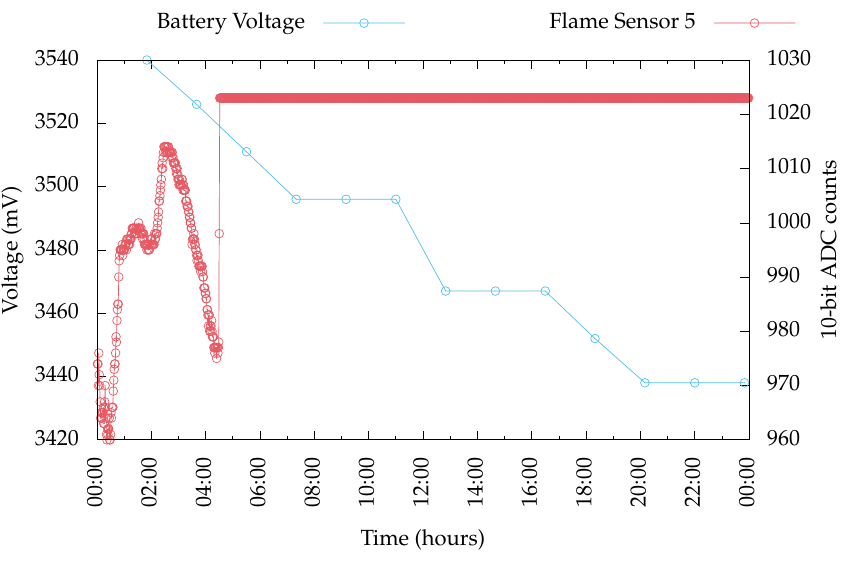
Figure 14. Battery voltage and flame sensor data from node 5FTH.